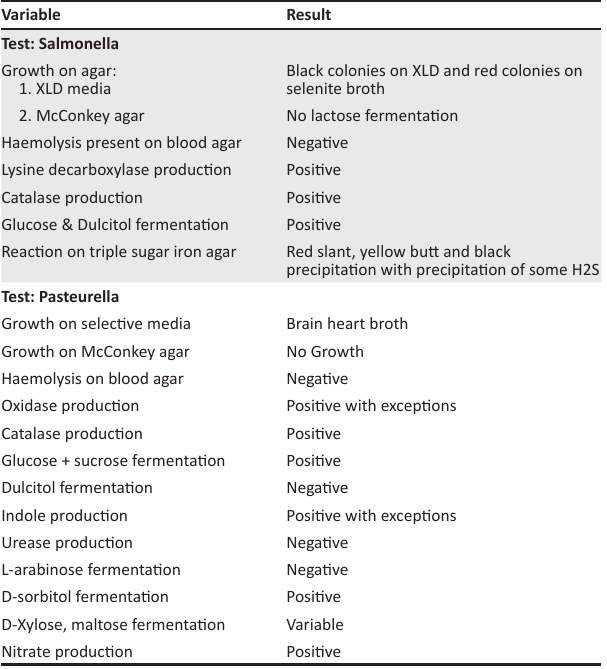
TABLE 2 : Assays for Salmonella Typhimurium and Pasteurella multocida isolation and confirmation. Variable